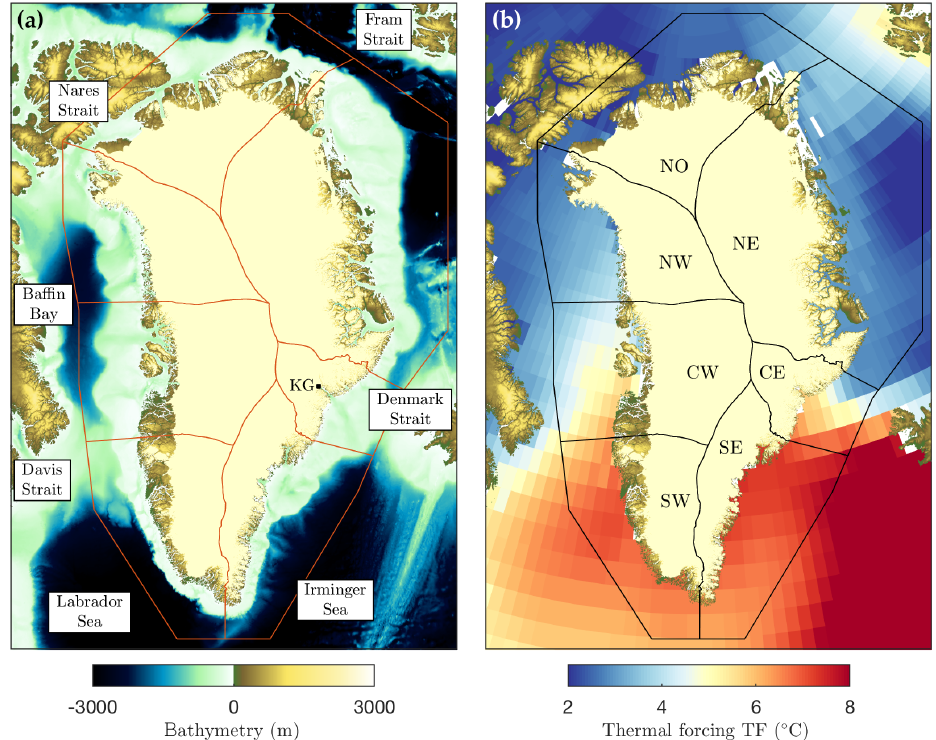
Figure 3. (a) Ocean bathymetry around Greenland (Schaffer and Timmermann, 2016) and (b) 200–500m depth-average, 1995–2014 time- averaged thermal forcing around Greenland from the EN4 dataset (Good et al., 2013). Red lines in (a) and black lines in (b) show the ice–ocean sectors over which the thermal forcing is averaged. The location of key geographic features mentioned in the text are shown in (a) with “KG” indicating Kangerdlugssuaq Glacier, while the ice–ocean sectors are labeled in (b) .